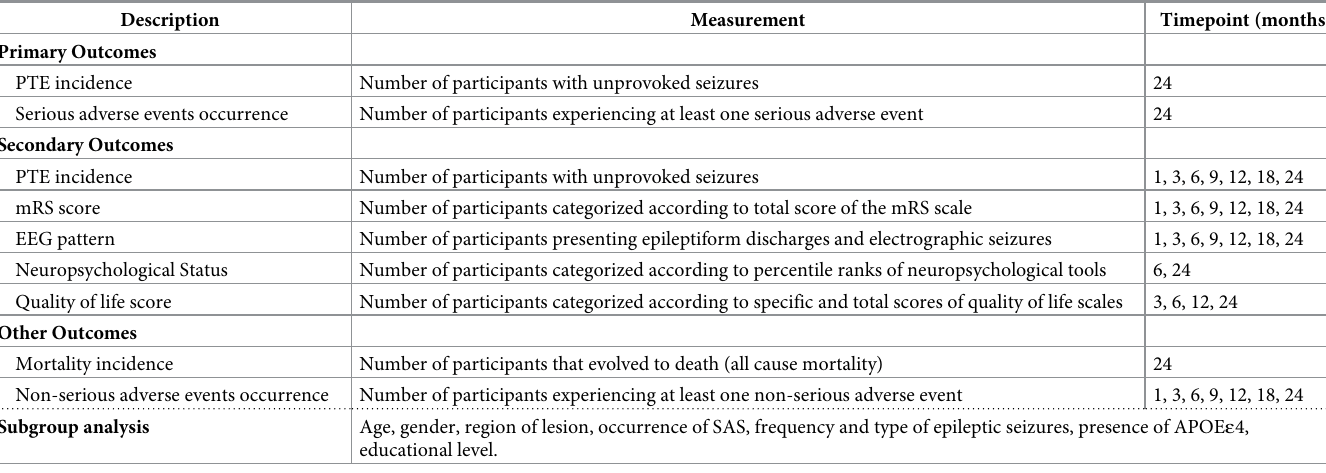
Table 1. Planned analysis for primary and secondary